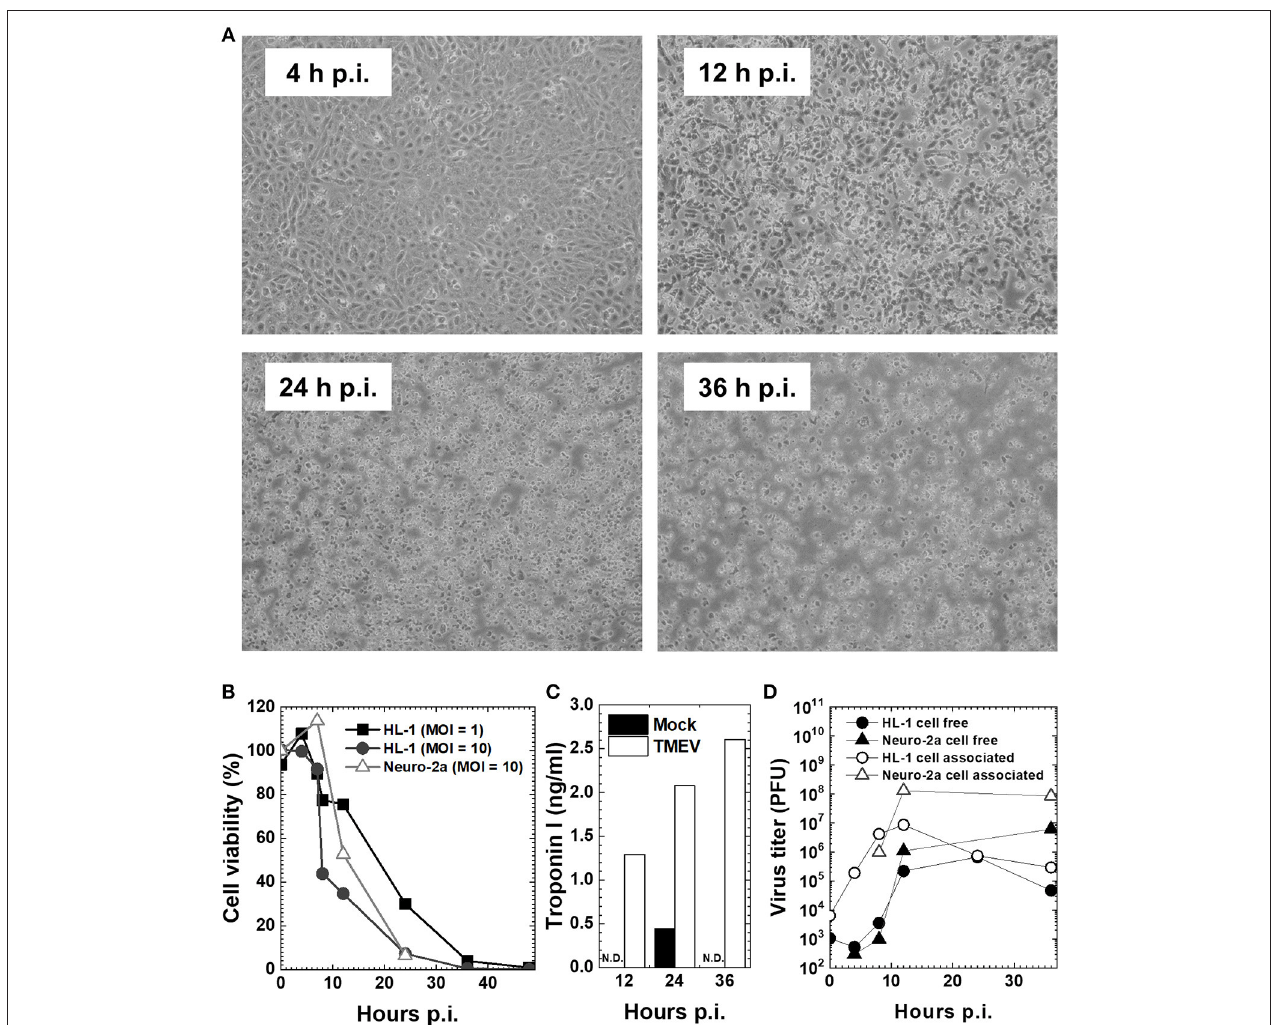
FIGURE 2 | Cardiomyocyte cell line HL-1 infection with the Daniels (DA) strain of TMEV (33, 42). (A) Confluent HL-1 cell monolayer infected with TMEV at a multiplicity of infection (MOI) = 10 showed no changes at 4hours (h) post-inoculation (p.i.). Cytopathic effect (CPE), including the rounding up and detachment of cells from the culture dish, was observed at 12h p.i., which developed cell lysis in most cells at 36h p.i. (B) HL-1 cells and neuroblastoma cell line Neuro-2a were infected with TMEV at an MOI = 1 or 10. Cell viability was determined with trypan blue dye exclusion assays. Cell viability of both HL-1 and Neuro-2a cells decreased at 12h p.i. and most cells died at 36h p.i. (C) The concentration of cardiac troponin I in cell culture supernatants determined by an enzyme-linked immunosorbent assay (ELISA) was detectable in TMEV-infected HL-1 cells (open column), but not detectable (N.D.) in mock-infected HL-1 cells (closed column) or infected Neuro-2a cell culture (data not shown). (D) Viral titers of cell-free (•, N ) and cell-associated virus ( ◦ , 1 ) in HL-1 or Neuro-2a cell culture were determined by plaque assays with baby hamster kidney (BHK)-21 cells (24). In both HL-1 and Neuro-2a cells, cell-free virus titers increased substantially at 12h p.i., while cell-associated viral titers increased at 8h p.i. and peaked at 12h